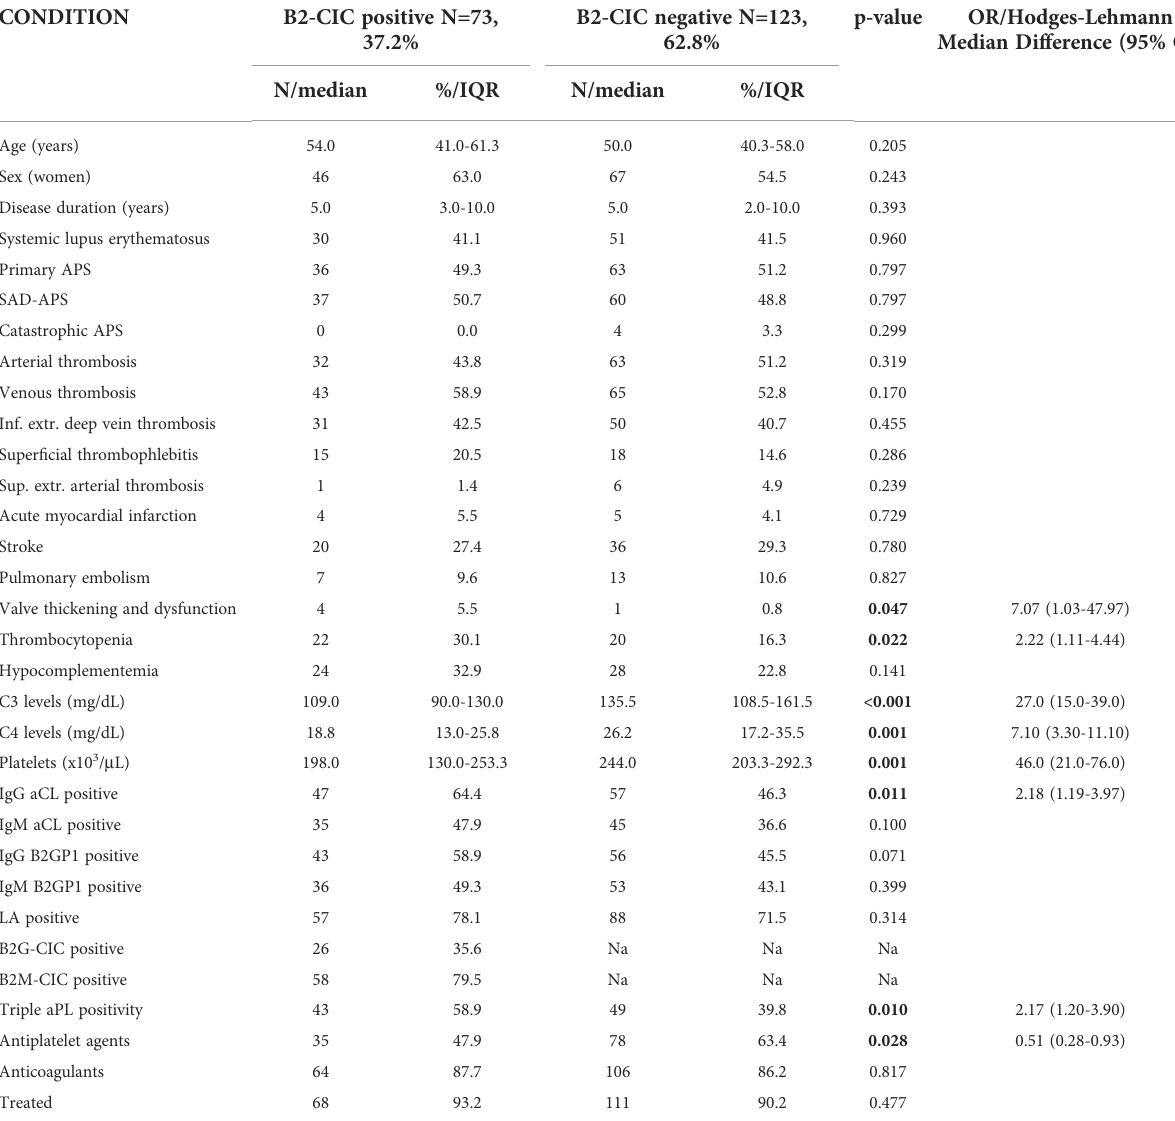
Table 3 Clinical, demographic and laboratory parameters of patients with isolated thrombotic APS, positive and negative for B2-CIC (N=196). ISOLATED THROMBOTIC APS (N=196)